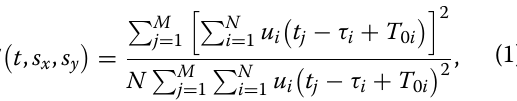
Fig. 8 An example of semblance analysis for three-component seismograms from the earthquake (November 25, 2012, 07:55:17 JST (UT Four panels in each component are, from top to bottom, seismograms ( a , e , and i ), slowness ( b , f , and j ), back-azimuth ( c , g , and k ), and maximum semblance value together with the RMS envelope ( d , h , and l ), respectively. The background color in slowness and back-azimuth plots represents semblance values. Circles in the same panels denote the slowness and back-azimuth with the maximum semblance value in every time step. The red and green arrows indicate the arrival times of P- and S-waves, respectively. Pink lines in c , g , and k indicate the back-azimuth to the event